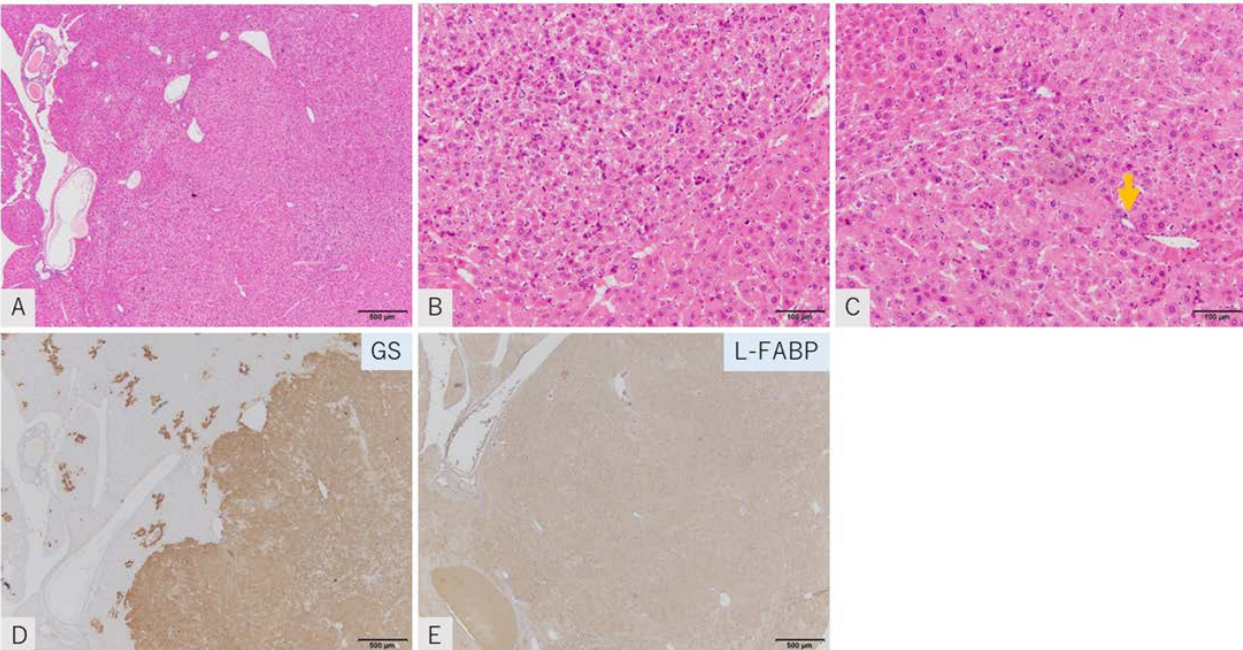
Figure 1. Representative images of GS-positive tumors. HE staining ( A – C ), immunostaining of GS ( D ) and L-FABP ( E ). Tumor shows a thick trabecular pattern of atypical hepatocytes with no capsule. Remnant bile ducts due to portal invasion are seen ( C : arrow). Tissue is positive for GS ( D ) and for L-FABP ( E ) (scale: A , D , E : 500 µ m; B , C : 100 µ m).